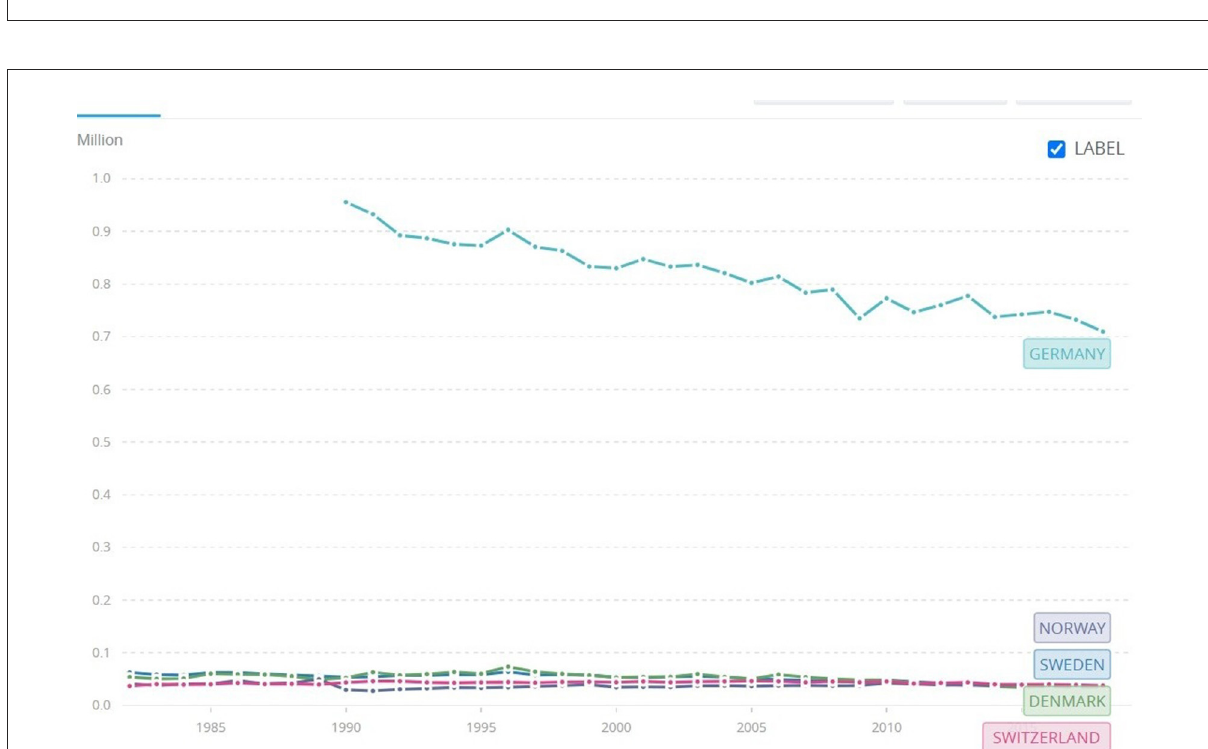
FIGURE6 Top-polluting nation-states. CO2 emissions since the 1980’s. Source: World Bank. At https://data.worldbank.org/indicator/EN.ATM.CO2E.KT? locations=RU-CN-US (accessed February 26, 2022).